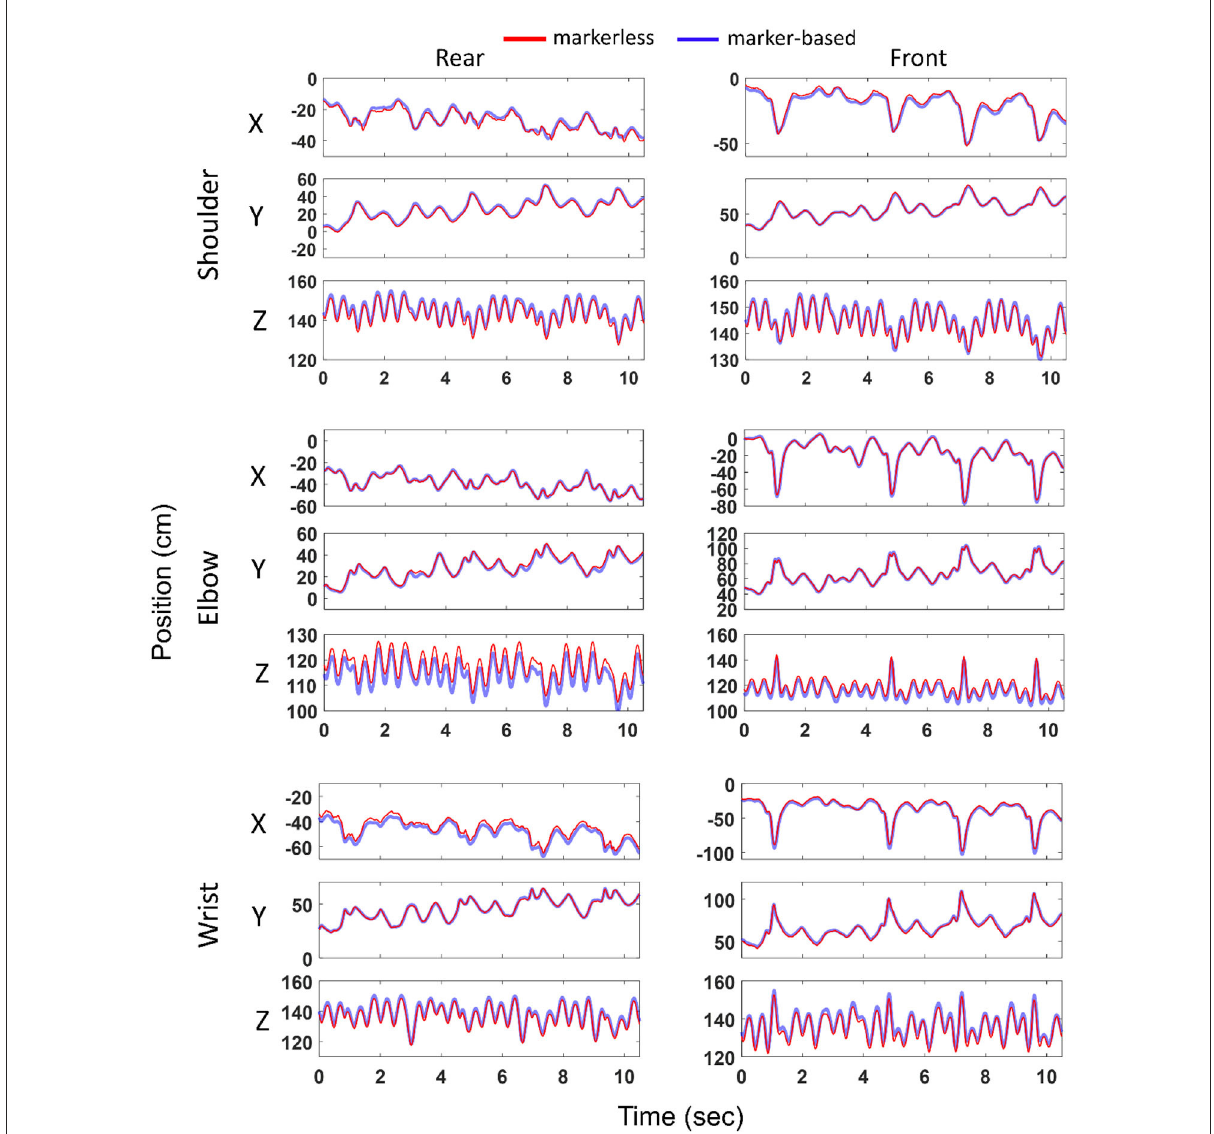
FIGURE2 Joint center positions (ordinate) at the shoulder, elbow and wrist in the global reference frame ( X , Y , Z ) computed with marker-based and markerless methods and represented over time (abscissa). Left and right columns represent joints of the rear and front limbs, respectively. Example shown for the second athlete and first boxing trial. Blue and red colors represent marker-based and markerless joint center positions, respectively.